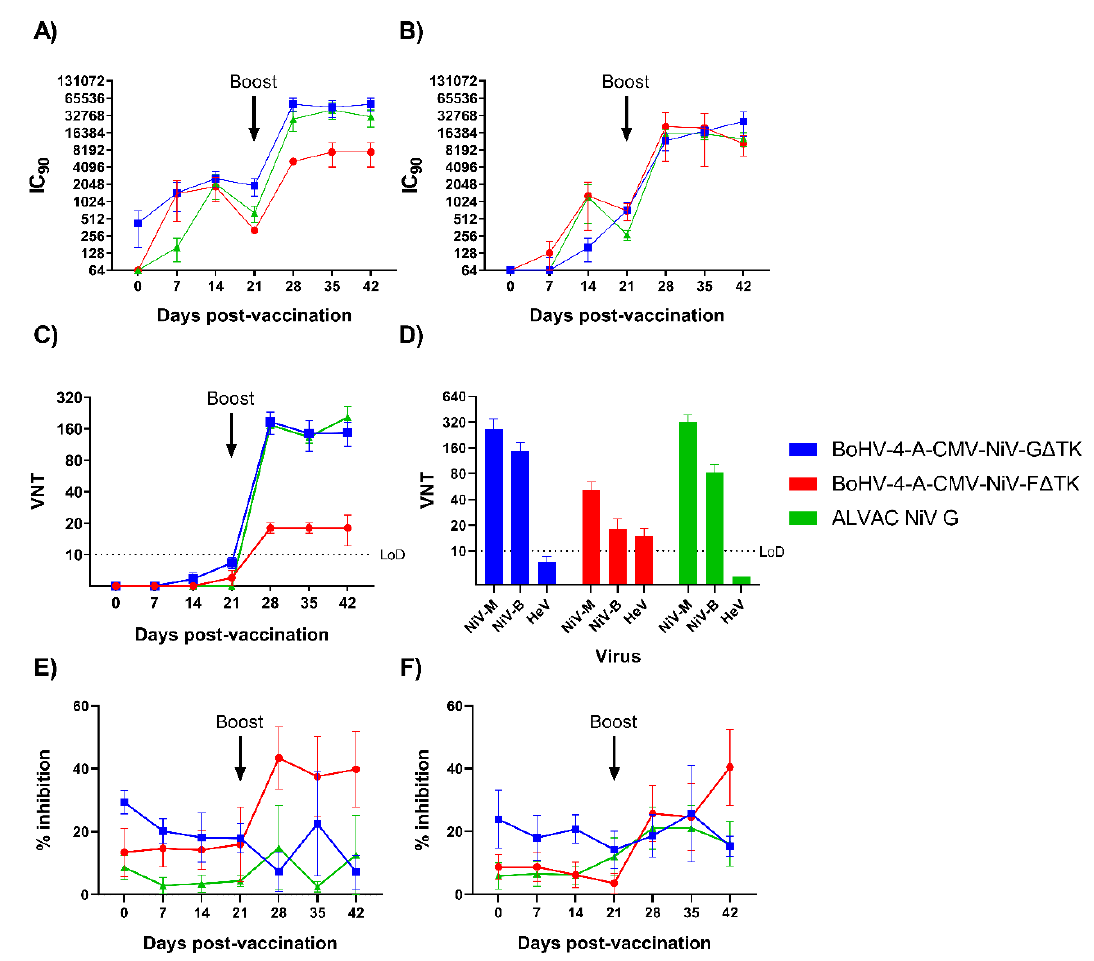
Figure 4. Evaluation of NiV neutralizing antibody responses following immunization of pigs with BoHV-4 vectors. Pigs were immunized with BoHV-4-A-CMV-NiV-F ∆ TK, BoHV-4-A-CMV-NiV-G ∆ TK or ALVAC NiV G on 0 (prime) and 21 (boost) dpv. NiV neutralizing antibody titers were assessed using NiV-M ( A ) and NiV-B ( B ) pseudoviruses and presented as the reciprocal serum dilution to inhibit pseudovirus entry by 90% (IC 90 ). Neutralizing antibody responses were confirmed by classical VNT; longitudinal serum samples were assessed for neutralization of NiV-B ( C ) and day 42 sera tested for cross-neutralization of NiV-M, NiV-B, and HeV ( D ). Sera was assessed for neutralization of NiV-mediated cell–cell fusion using a quantitative fusion assay with cells expressing NiV-M ( E ) or NiV-B ( F ) glycoproteins. Mean data ± SEM are shown for each vaccine group. A classical VNT, utilizing NiV-B, revealed low titers of virus neutralizing antibodies in 3 / 6 BoHV-4-A-CMV-NiV-G ∆ TK pigs, 1 / 5 BoHV-4-A-CMV-NiV-G ∆ TKpigs and 0 / 6 ALVAC NiV G